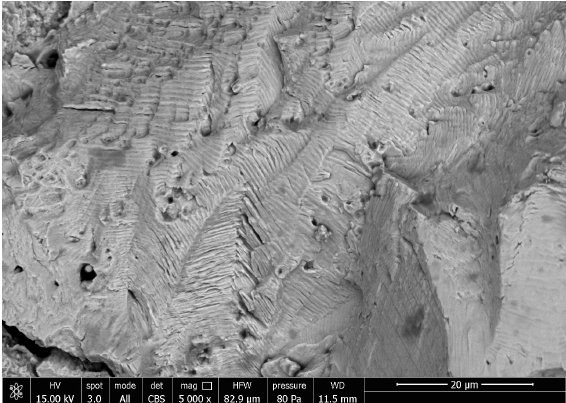
Figure 12. Intergranular fracture observed in specimens extracted from Bar B